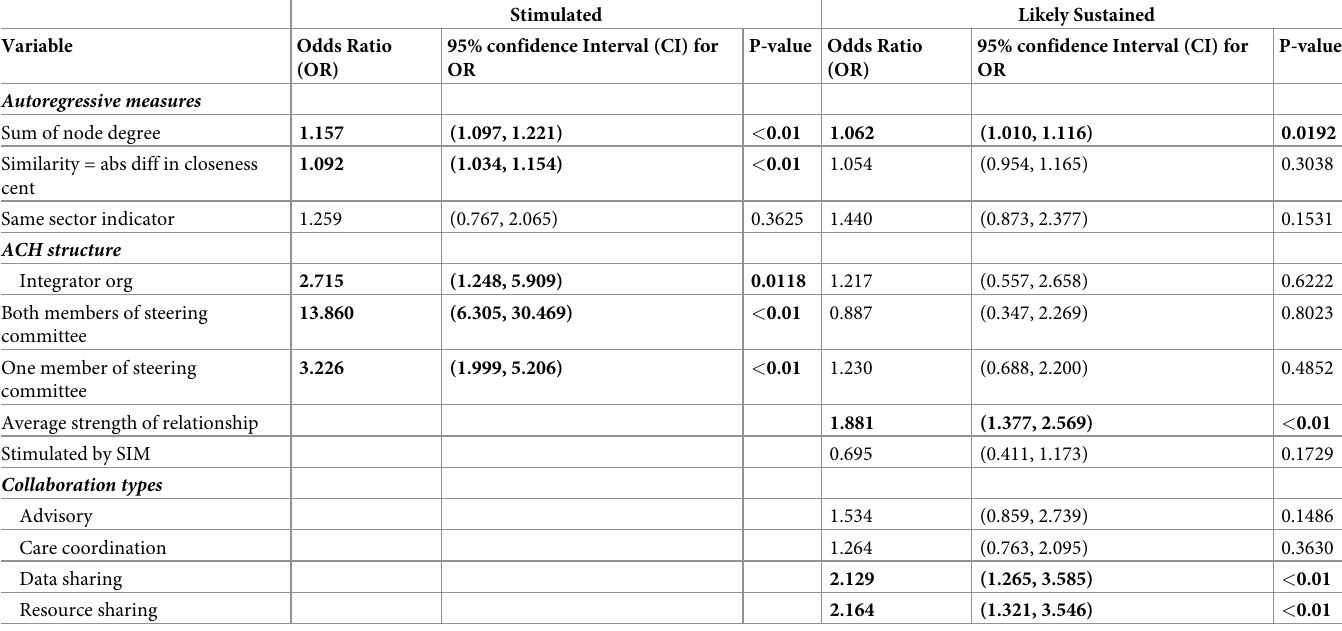
Table 2. Network variables associated with stimulated and likely sustained edges in Iowa ACH